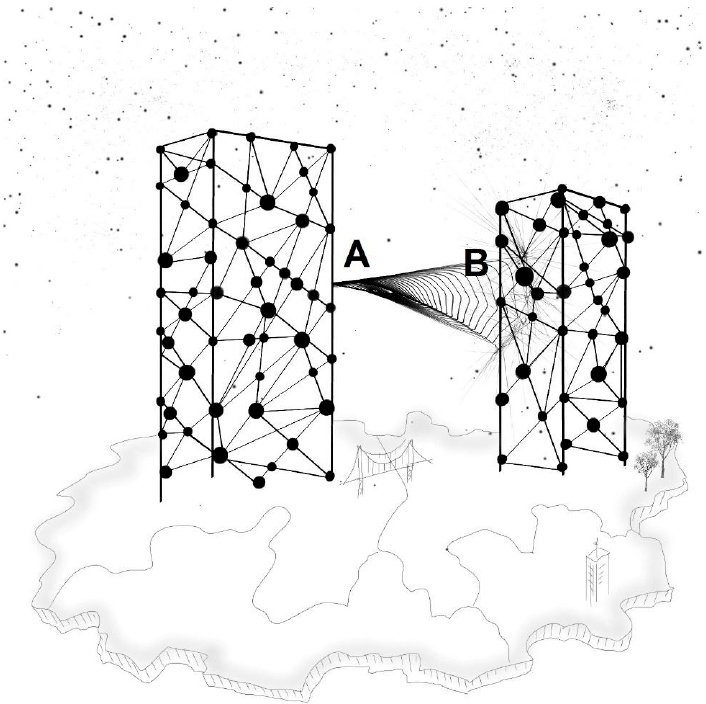
Figure 1. Schematic image of a Free-space Optical Communication link between two nearby skyscrapers, serving e.g., to create a LAN-to-LAN connection between A and B points.